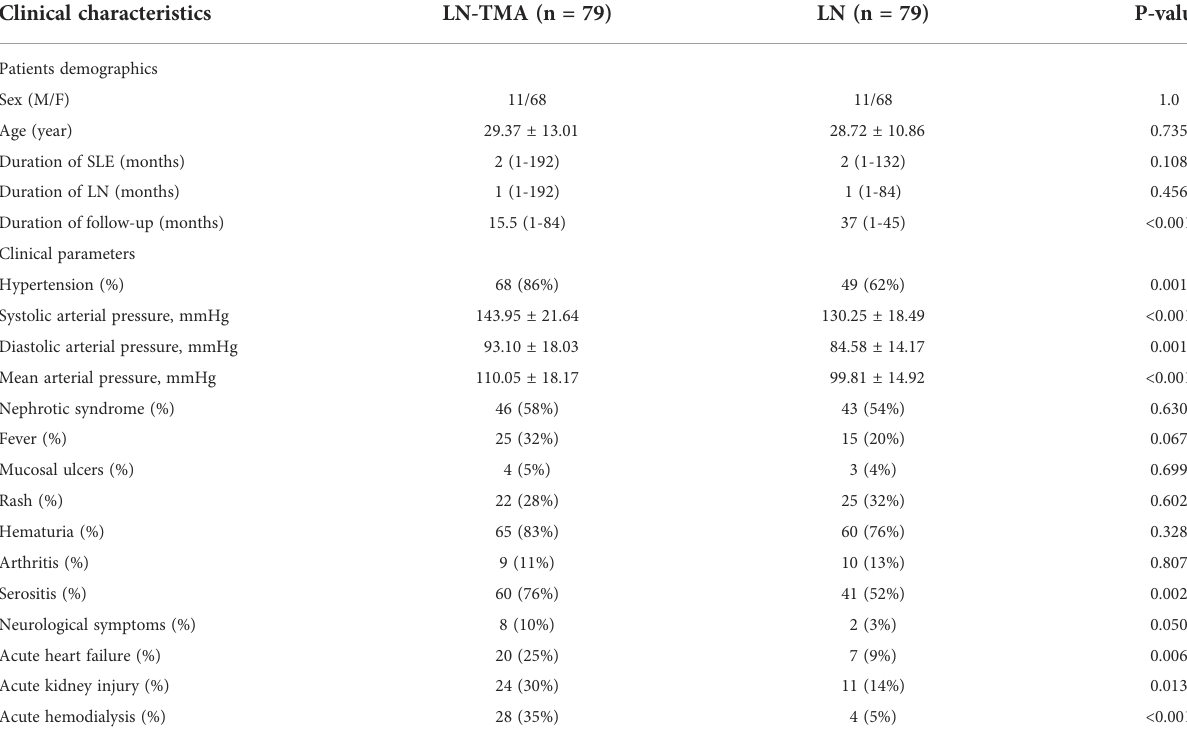
TABLE 1 Clinical characteristics of lupus nephritis patients with or without renal thrombotic microangiopathy. Clinical